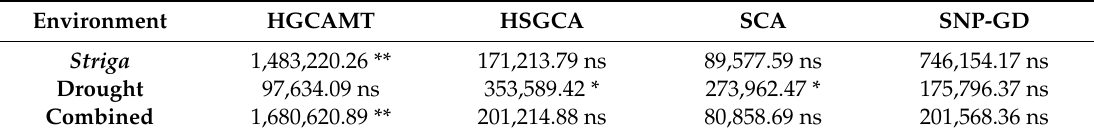
Table 7. Mean squares of grain yield of clusters identified by di ff erent grouping methods under drought, Striga, and combined environments, between 2015 and 2017. Environment HGCAMT HSGCA SCA SNP-GD Striga 1,483,220.26 ** 171,213.79 ns Drought Combined 1,680,620.89 ** 201,214.88 ns 201,568.36